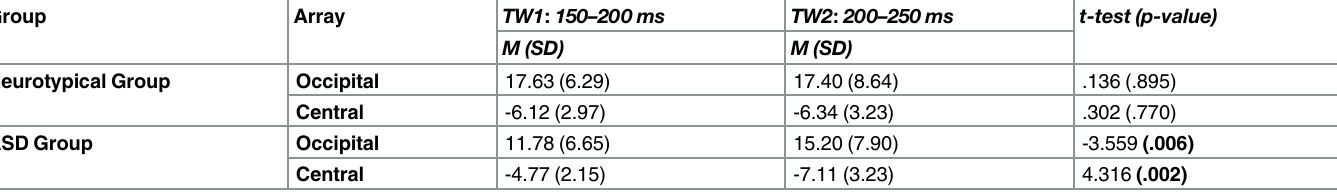
Table 2. Mean and standard deviations of the amplitude of the Occipital and Central arrays to the picture (P1 peak) at the two time windows for the two groups.